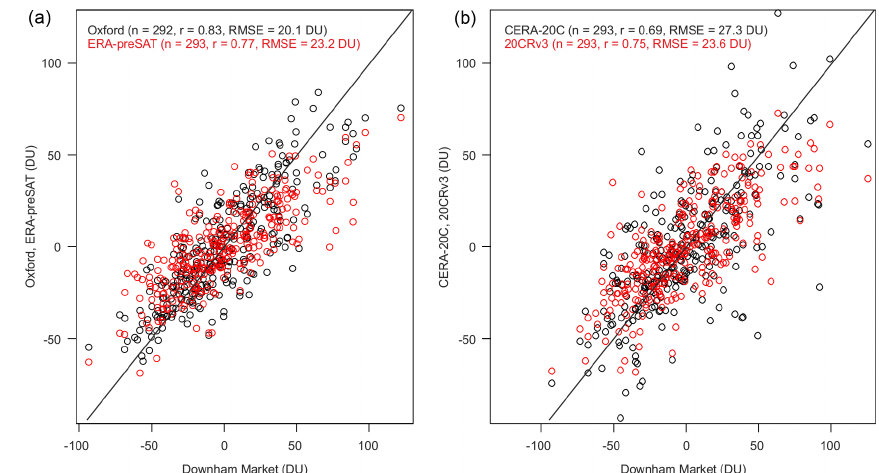
Figure 8. Scatter plot of deseasonalised total column ozone data at Downham Market against (a) measurements performed in Oxford as well as total column ozone data from the closest grid cell in ERA-PreSAT and (b) total column ozone data from the closest grid cell in 20CRv3 and CERA-20C (ensemble mean). The one-to-one line is shown in black. The numbers in brackets indicate the number of data points, correlations, and root mean squared errors in DU.